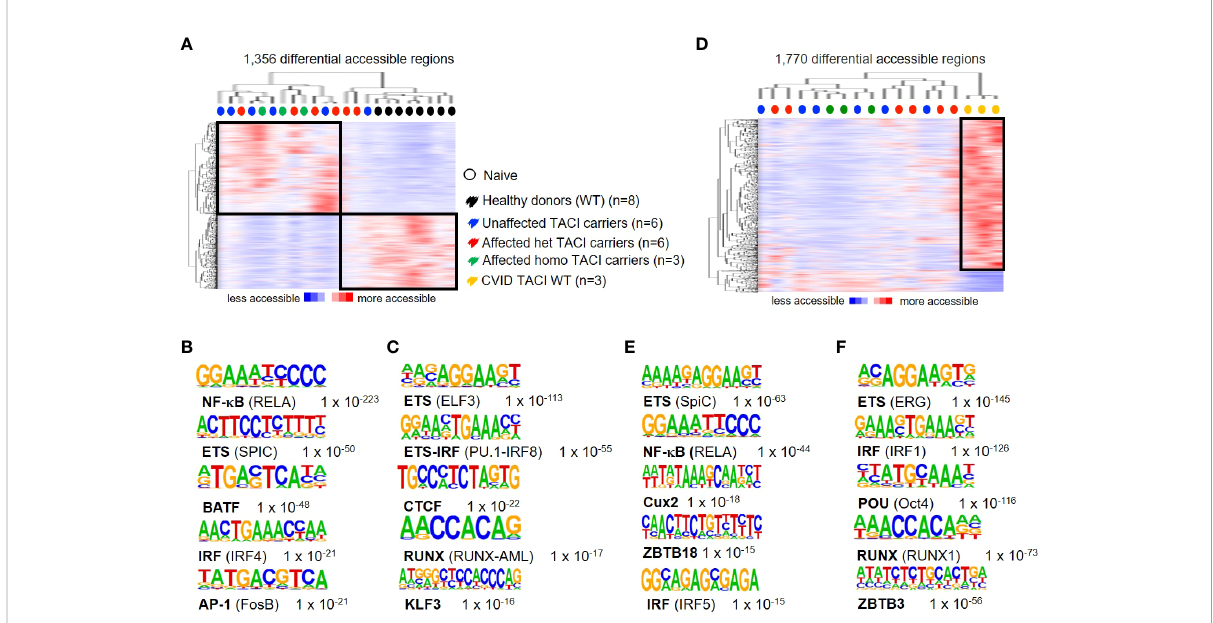
FIGURE 2 Dysregulated chromatin landscape in unstimulated naïve B cells from TACI mutation carriers. (A) Heatmap including hierarchical clustering of 1,356 differentially accessible chromatin regions in TACI mutation carriers compared to WT. Preferentially open regions amounted to 743 in TACI mutation carriers and 613 in WT. (B, C) Cis-regulatory sequences associated with regions of the (B) TACI mutation carriers or (C) WT. (D) Heatmap including hierarchical clustering of 1,770 differentially accessible chromatin regions in TACI mutation carriers compared to CVID TACI WT. Preferentially open regions amounted to 223 in TACI mutation carriers and 1,547 in CVID TACI WT. (E, F) Cis-regulatory sequences associated with the regions of the (E) TACI mutation carriers or (F) CVID TACI WT. Genes were normalized and centered with Cluster 3.0 and visualized with Java Treeview with color indicating the region with maximum (red) or minimum (blue) open chromatin. Sequence logos and p - values re fl ecting the signi fi cance of motif occurrence are shown next to the corresponding